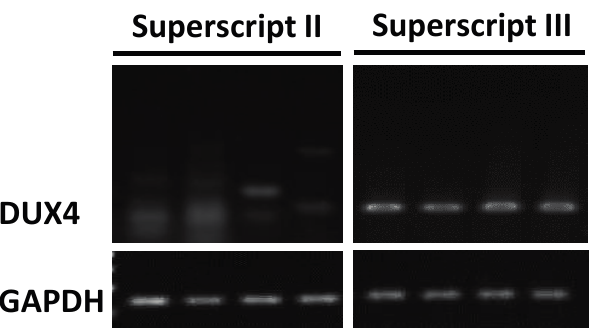
Figure 1. DUX4 was detected in cDNA synthesized using Superscript III but not Superscript II. Four independent cultures of immortalized FSHD myoblasts in growth medium with 15% KOSR (without dexamethasone) were examined for each group. cDNA samples were synthesized using either Superscript II (left panel) or Superscript III (right panel). Oligo(dT) primers were used for this